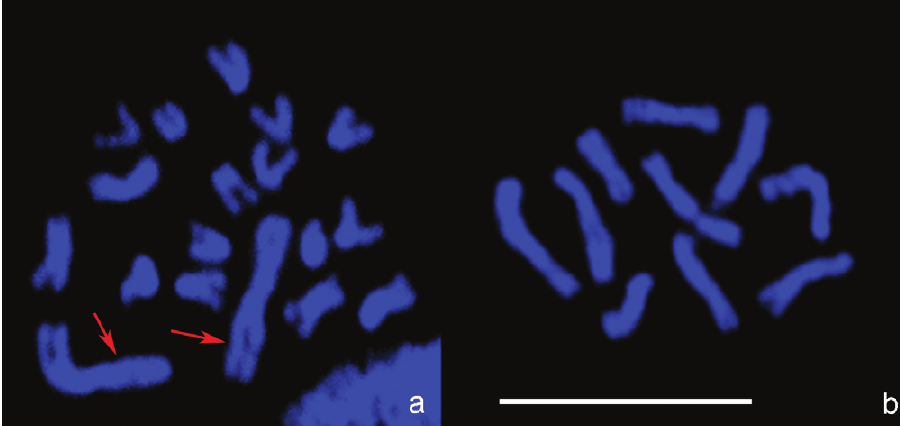
Figure 3. Confocal microscopic images. a L. boulardi , diploid metaphase plate b - L. heterotoma , haploid metaphase plate. Arrows point to the pair of large metacentric chromosomes in the karyotype of L. bou- lardi that presumably arose via chromosomal fusion in an ancestral chromosome set with n = 10. Scale bar 10